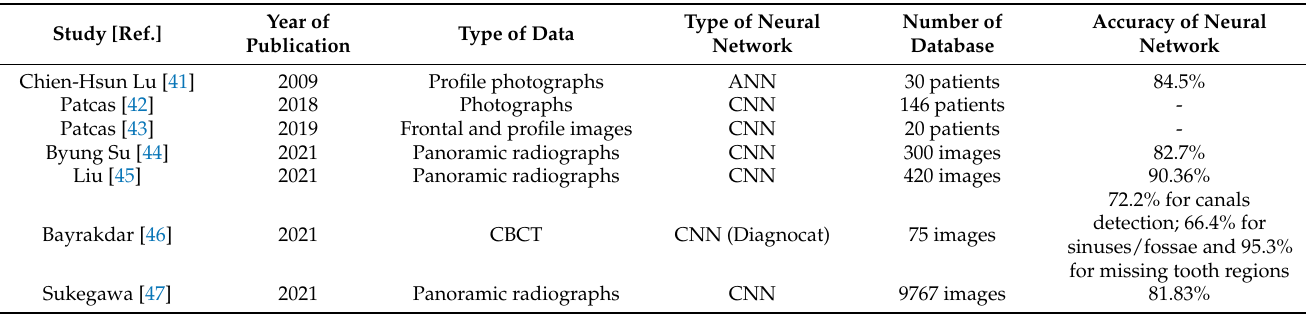
Table 4. Baseline characteristics of the studies included in review by studying neural networks in dental